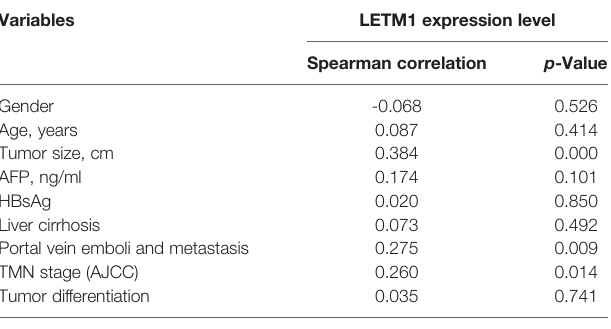
TABLE 2 | Spearman analysis of correlation between LETM1 and clinicopathological. Variables LETM1 expression level